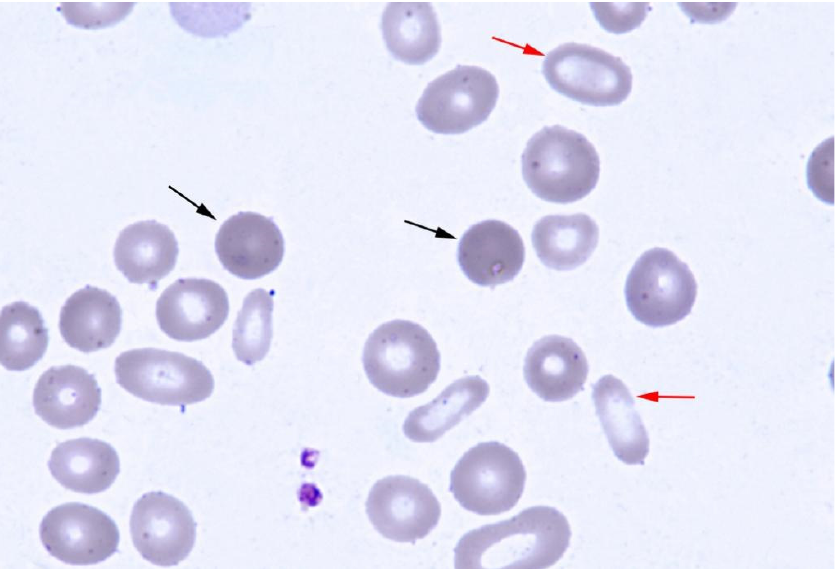
Figure 1. Peripheral blood smear shows anisocytosis, and spherocytes (black arrow) and elliptocytes (red arrow) could be seen easily (Wright’s stain).